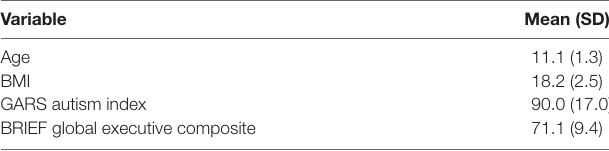
TABLE 1 | Demographic characteristics of the participants.